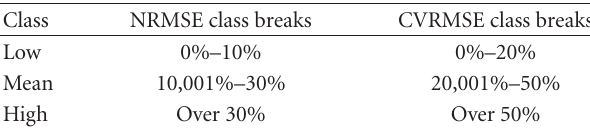
Table 4: Breaks of the three thematic classes of NRMSE and CVRMSE.